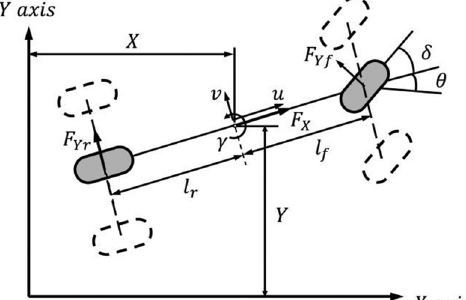
Figure 2 Illustration of vehicle